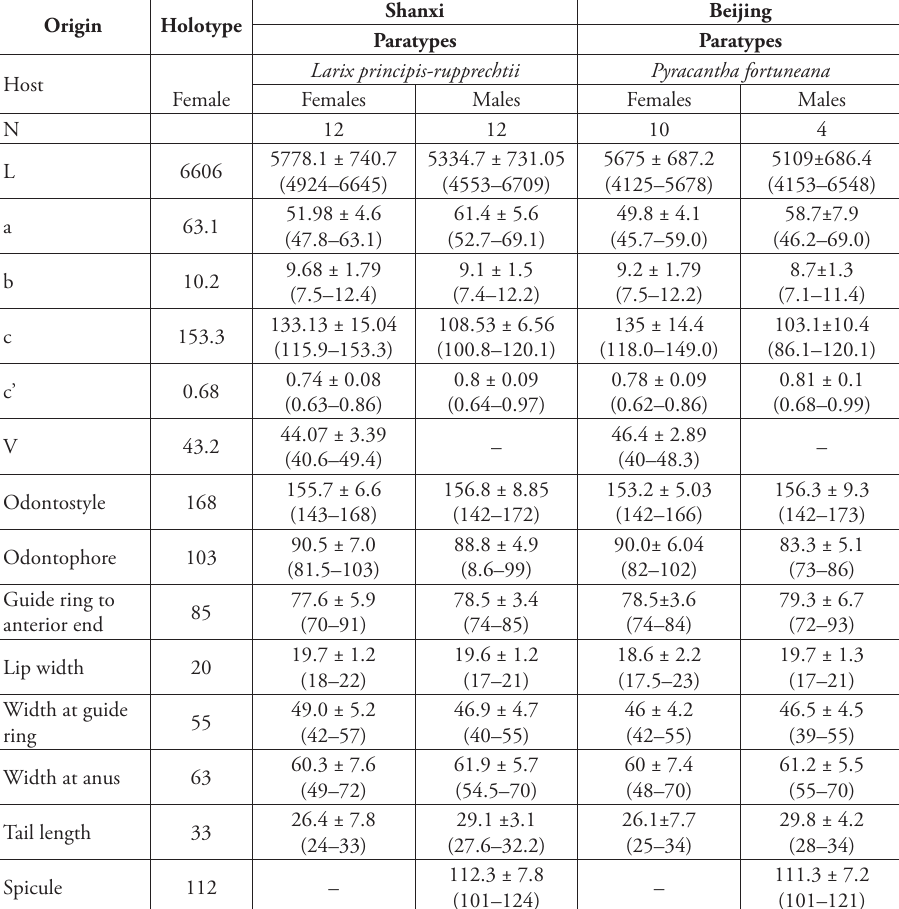
Table 1. Measurements (in μm and in the form, mean ± standard deviation and range) of females and males of Longidorus cheni sp. n. from two provinces in